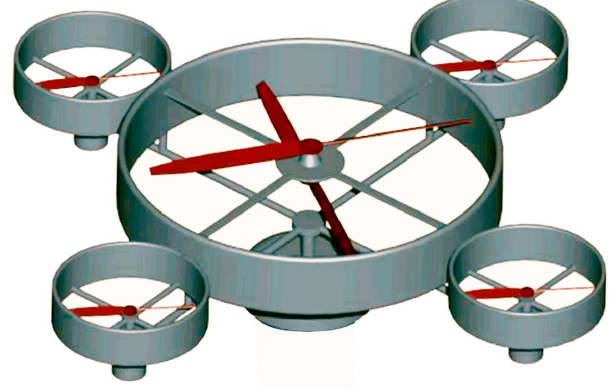
Figure 1. The layout of the modified UAV [54].